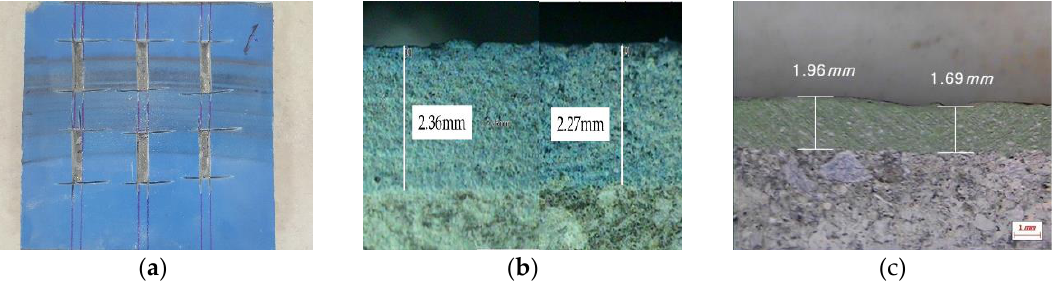
Figure 10. Test result of abrasive wear resistance. ( a ) Collection for depth measurement. ( b ) Surface thickness difference before and after the test in SA+PR30%. ( c ) Surface thickness difference before and after the test in WPC.